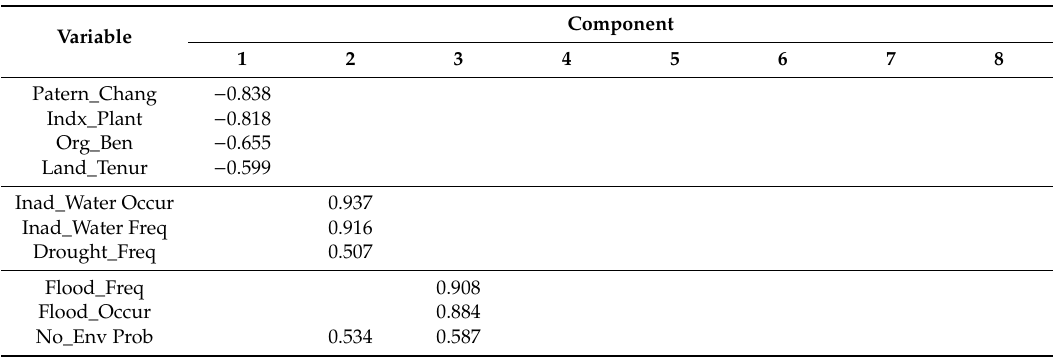
Table 11. Distributed variables for each component as output from the principle component analysis (PCA) pattern